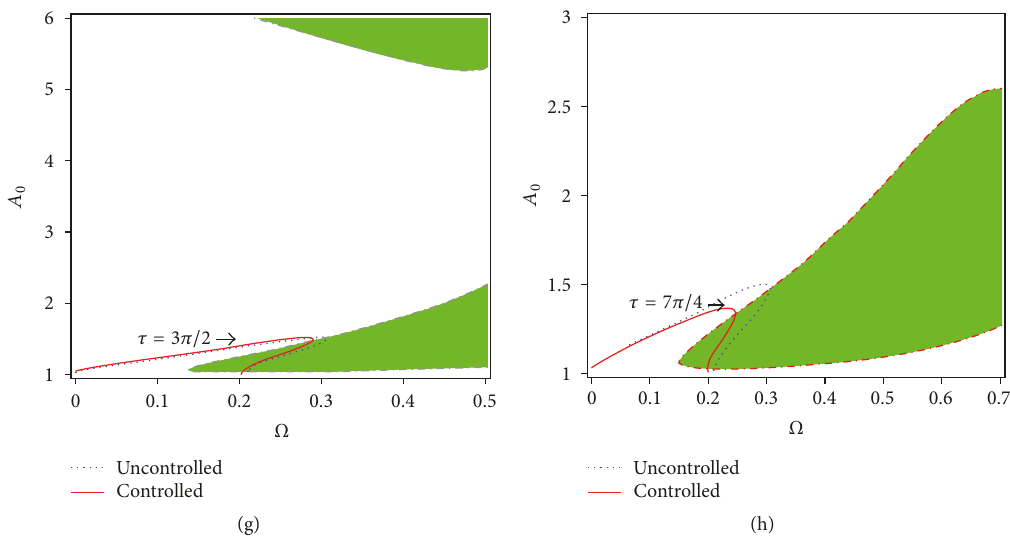
Figure 5: Comparison between the amplitude-frequency responses of controlled and uncontrolled systems: 𝑐 = 0.2 ; 𝑏 = 0.02 ; 𝑓 = 0.3 . Solid lines: the responses of controlled system; dash lines: the responses of uncontrolled system; shaded regions: unstable regions. (a) 𝜏 = 0.0 ; (b) 𝜏 = 𝜋/4 ; (c) 𝜏 = 𝜋/2 ; (d) 𝜏 = 3𝜋/4 ; (e) 𝜏 = 𝜋 ; (f) 𝜏 = 5𝜋/4 ; (g) 𝜏 = 3𝜋/2 ; (h) 𝜏 = 7𝜋/4 .